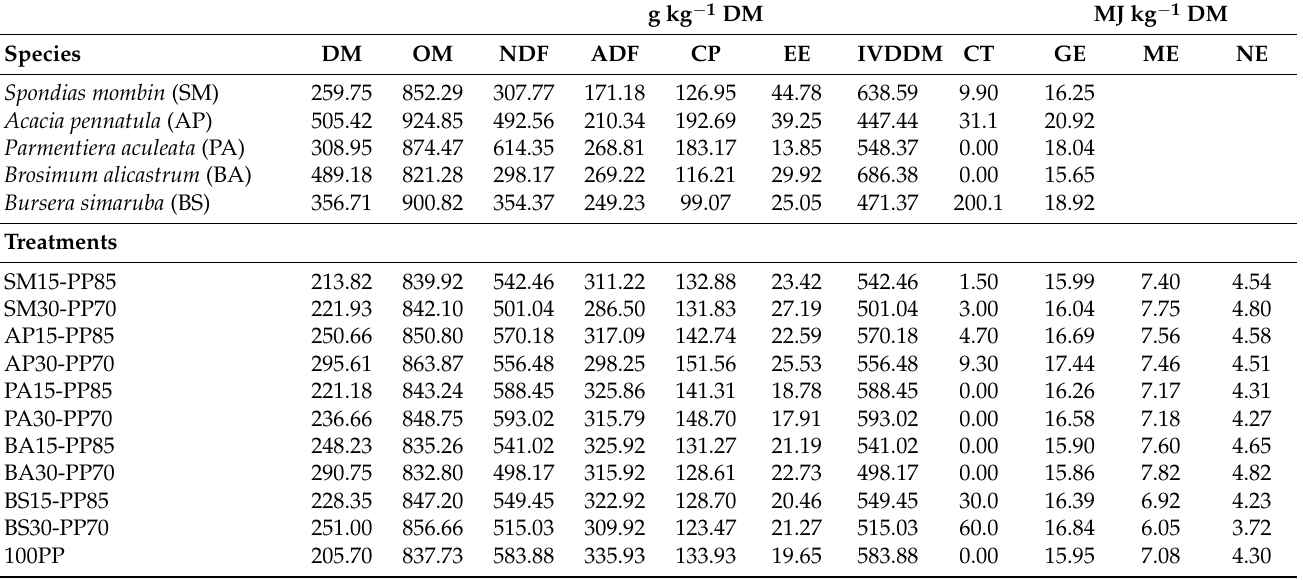
Table 1. Chemical composition, condensed tannin content and in vitro digestibility of forage species and